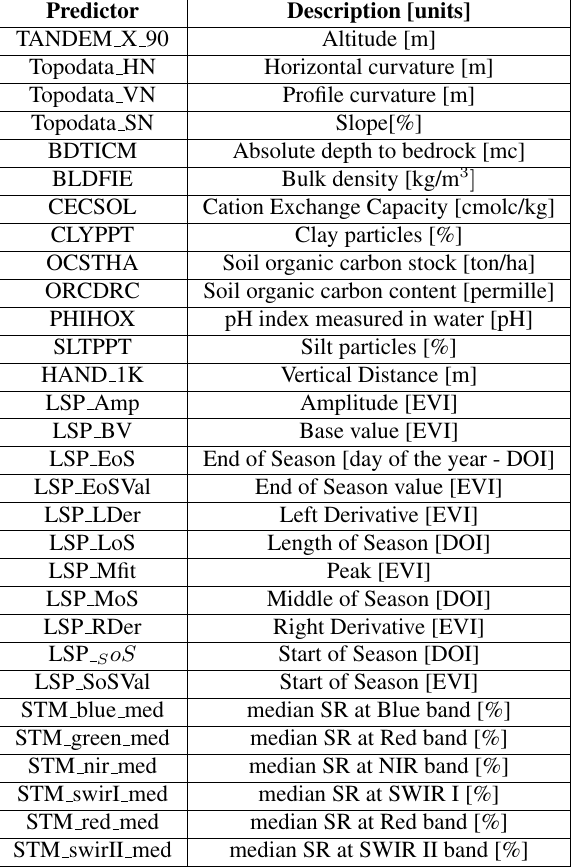
Table 2. Selected variables, their brief description and its units of measurement.